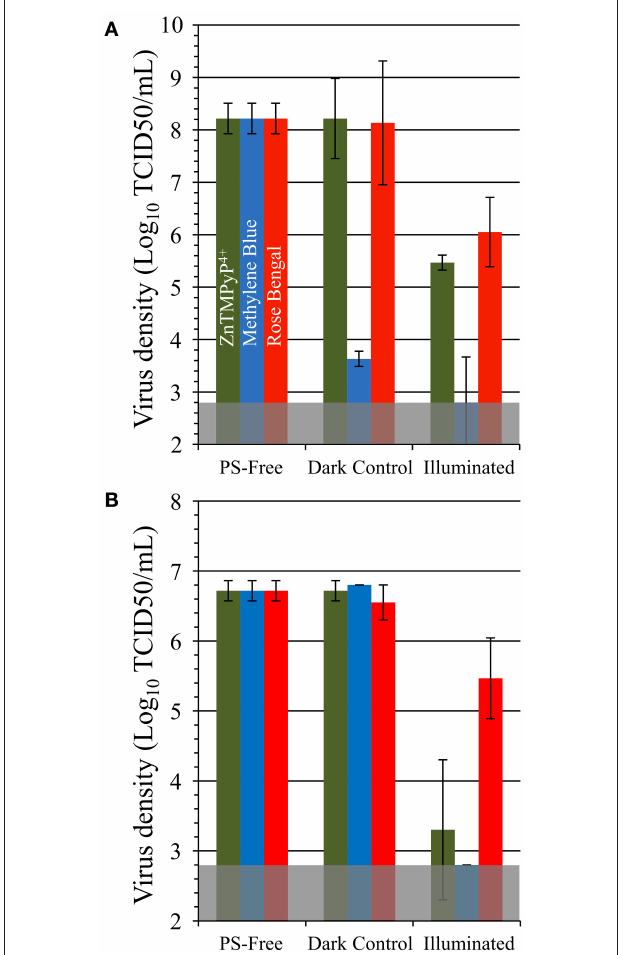
FIGURE 8 | Antiviral photodynamic inactivation efficacy of Vescom materials coated with SbQ-PVA/ZnTMPyP 4 + , SbQ-PVA/MB, and SbQ-PVA/RB for (A) feline calicivirus (FCV) and (B) adenovirus. Experimental conditions were the same as those listed in Figure 6